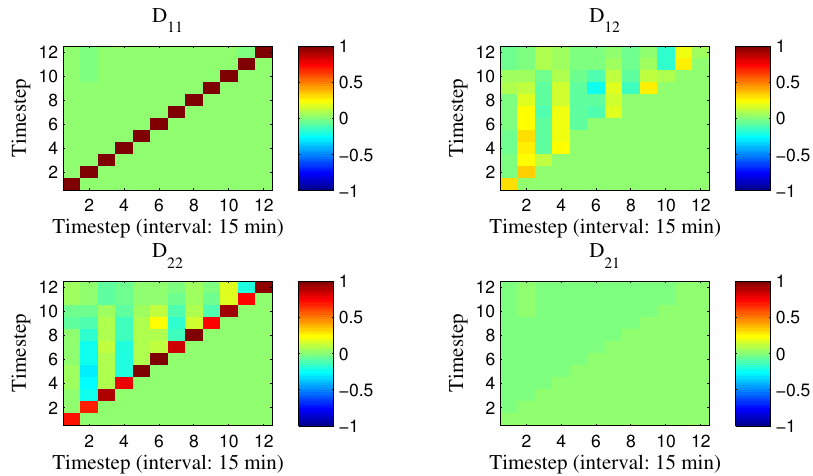
Figure 8. Policy of reserve allocation for three-cell power system in Scenario